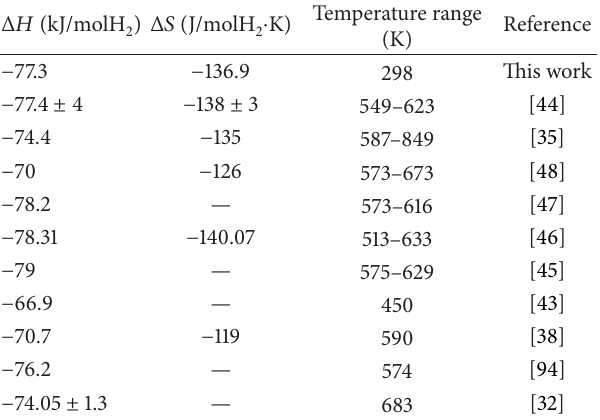
Table 2: Enthalpy and entropy of formation of MgH